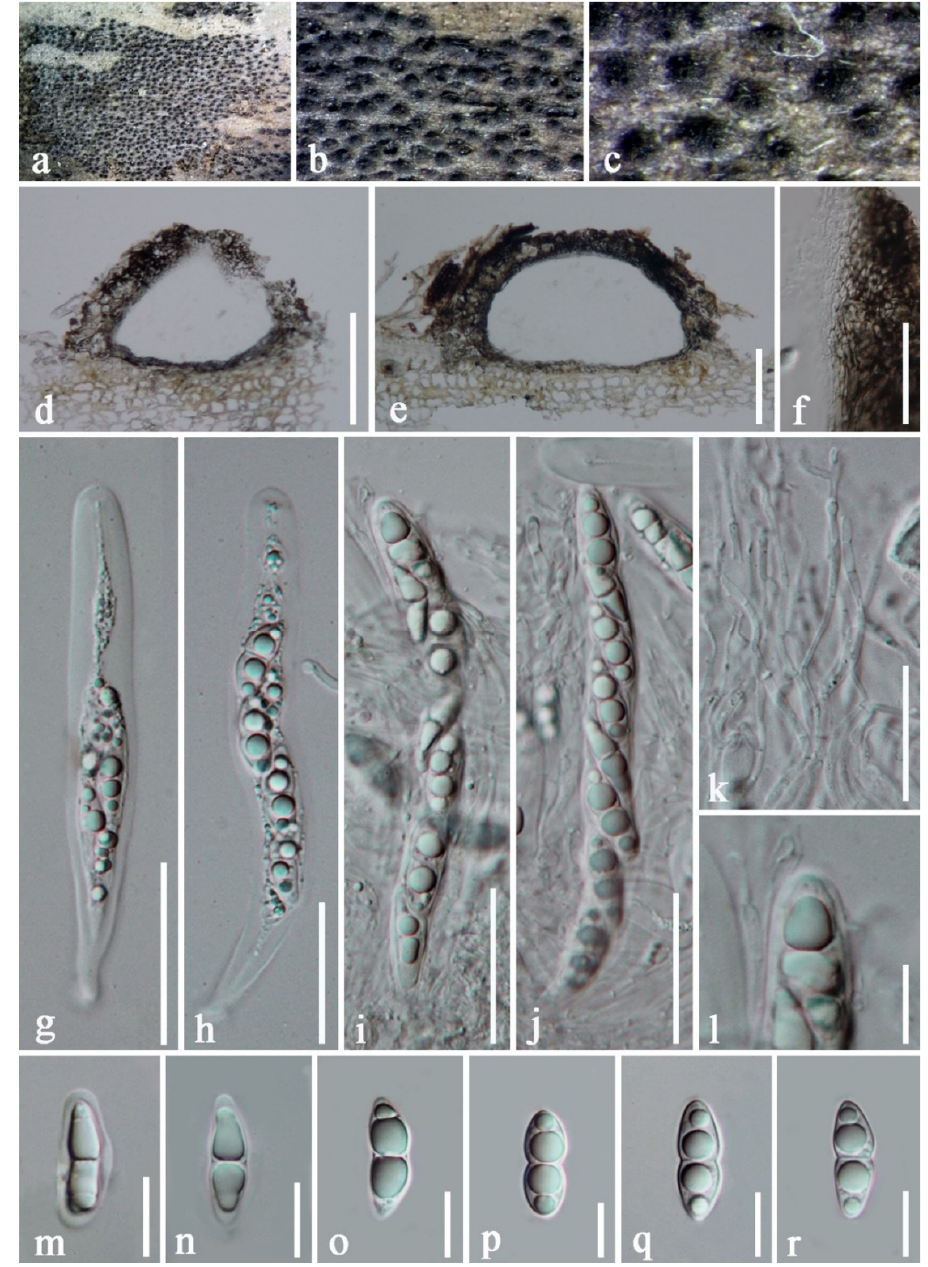
Figure 6. Periconia didymosporum (MFLU 15-0057, holotype of Bambusistroma didymosporum ). ( a – c ) Ascomata developing on bamboo culm; ( d , e ) vertically section of ascomata; ( f ) section through peridium; ( g – j ) immature and mature asci; ( k ) pseudoparaphyses; ( l ) an apical ascus; ( m – r ) ascospores. Scale bars: ( d , e ) = 100 µm, ( f – k ) = 30 µm, ( l – n ) = 10 µm. Photo credit by D.Q. Dai. Periconia pseudobyssoides Markovsk. and Kaˇcergius, Mycol. Progr. 13(2): 293 (2013) [2014] Figure